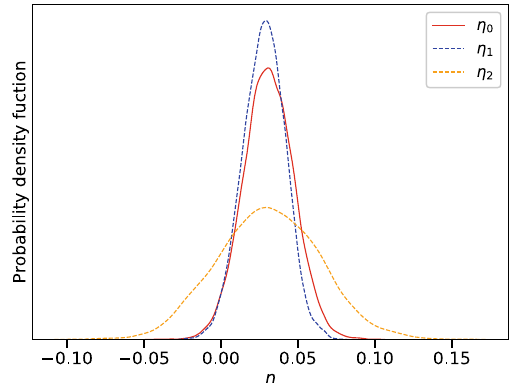
Fig. 7 The posterior probability density function with three parame- terized forms η j ( j = 0 , 1 , 2) by using ANN reconstructed HII galaxy and compact radio quasar samples